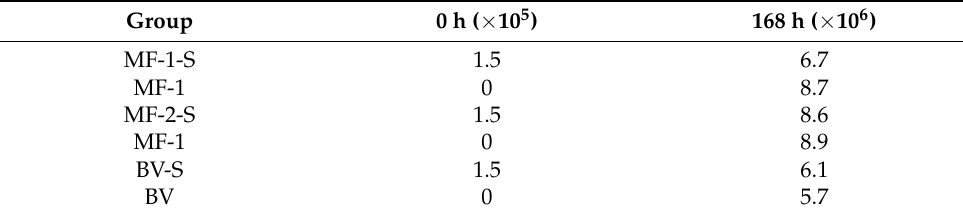
Table 3. Total number of bacteria analyzed by